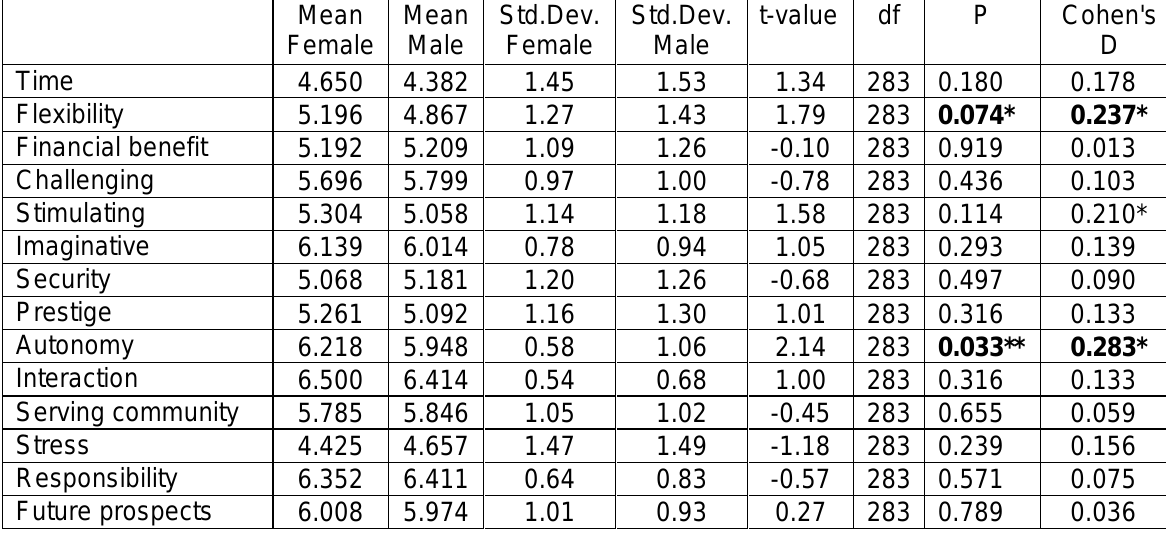
Mean Mean Std.Dev. Female Male